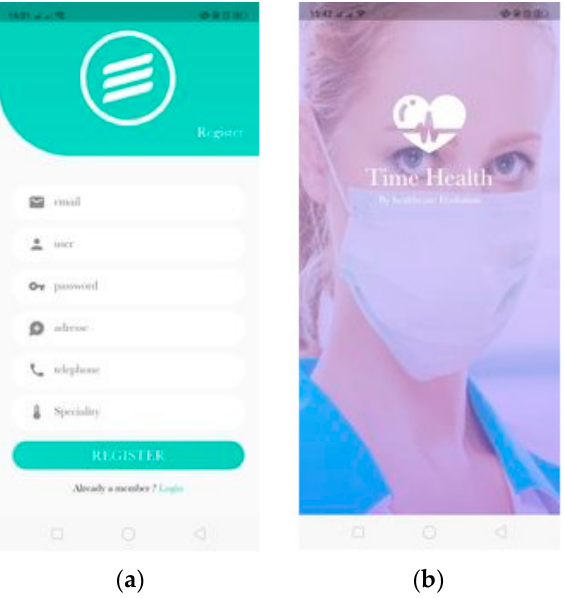
Figure 8. Used SW applications.